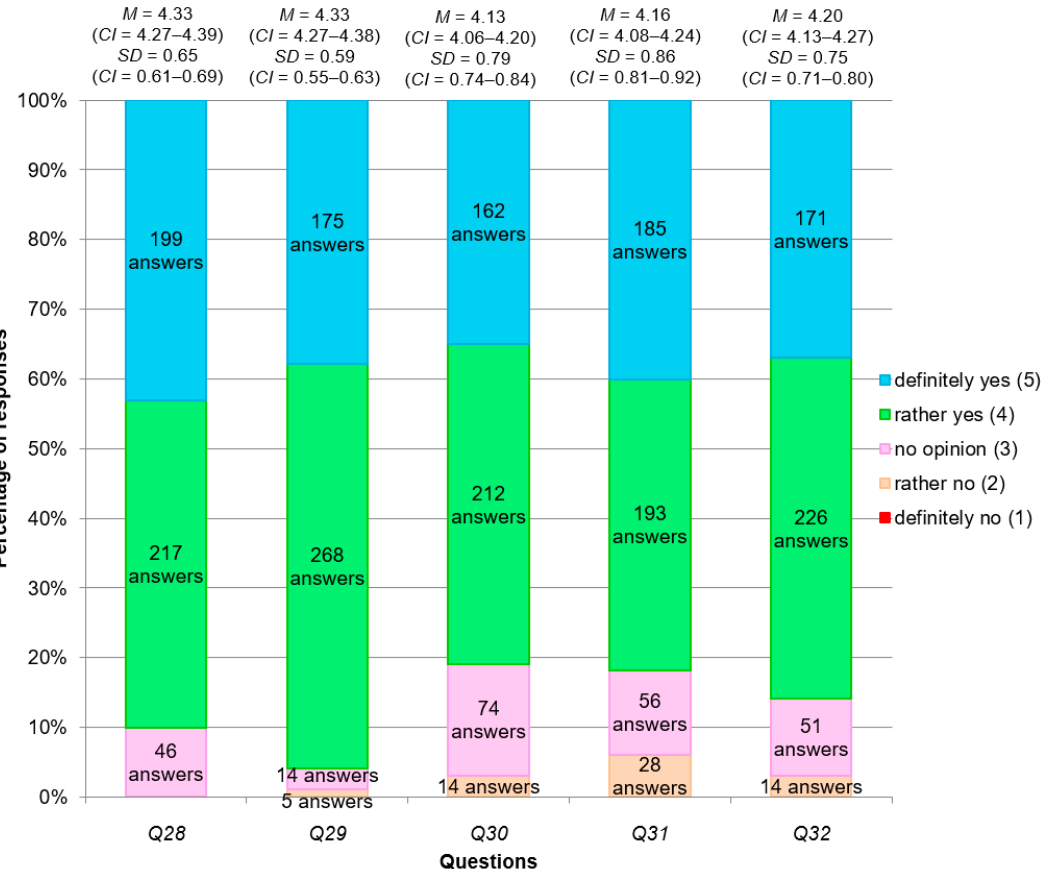
Figure 13. Assessment of operational and technical factors influencing the choice of an alternative energy source for heating water in residential buildings ( M —average, SD —standard deviation, CI —confidence interval; questions numbers ( Q ) according to the Appendix A).